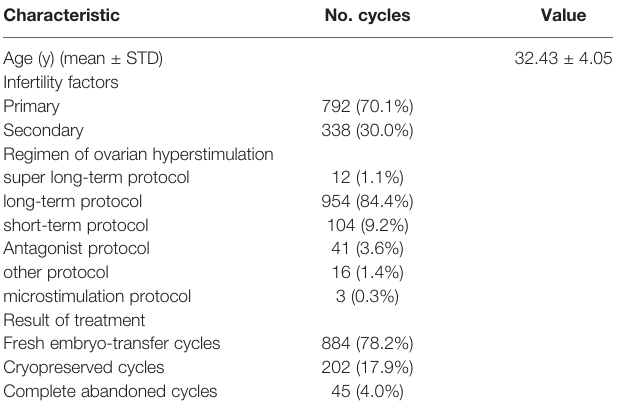
TABLE 1 | Characteristics of the 1130 half-ICSI patients. Characteristic